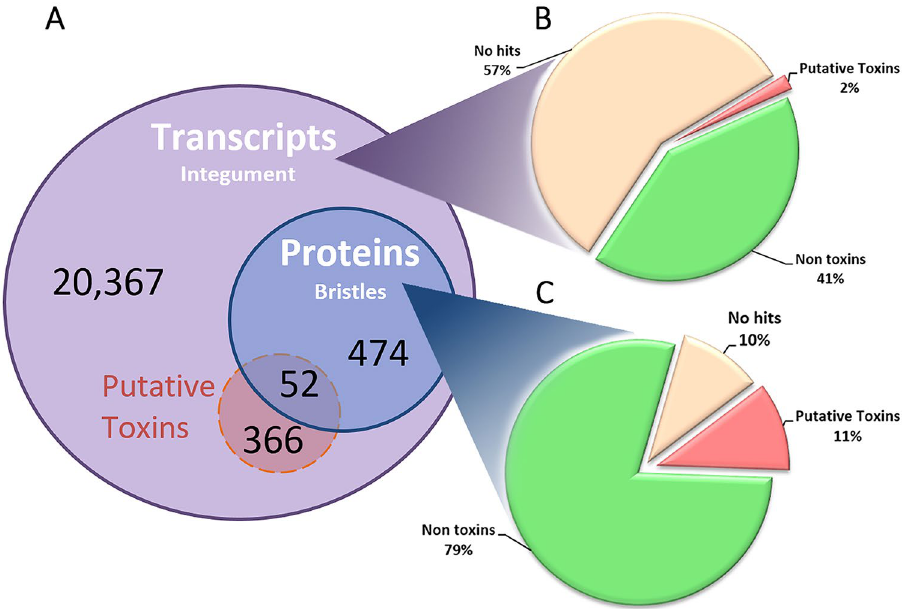
Figure 1. Global and integrative transcriptomic and proteomic analyses. ( A ) Venn diagram showing a general overview of the transcripts in the integument of pararama caterpillar, identified by NGS, and bristle proteins by mass spectrometry. The transcriptome contained 21,256 transcripts (purple), among which 418 have similarity to known toxins (red). Proteomic analysis was performed using the transcriptome database, and 526 transcripts were found (blue), among which 52 showed similarity with known toxins. ( B ) Pie chart showing the number of transcripts in the integument, among which 57% were no hits, 41% were non-toxins and 2% were putative toxins. ( C ) Pie chart showing proteins from the bristles extract, among which 10% were no hits, 79% were non- toxins and 11% were putative toxins. The figure was drawn using Microsoft Excel version 1.5 (www.micro soft.